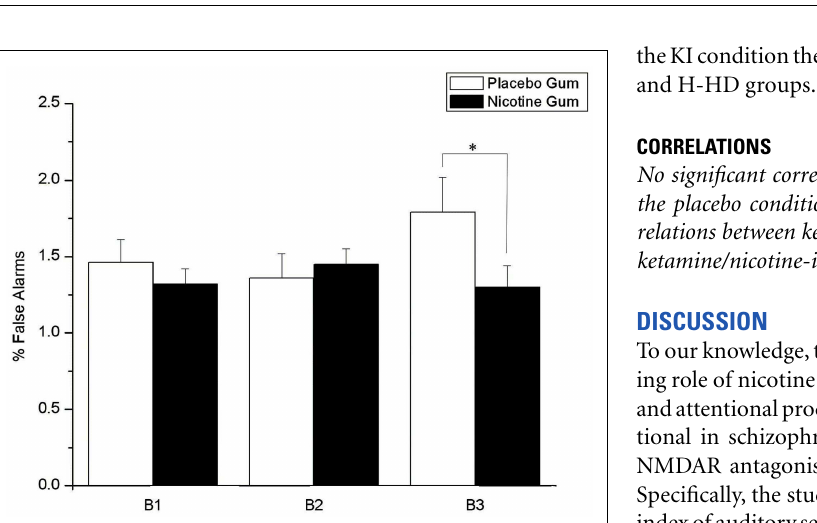
FIGURE 6 | Effects of placebo and nicotine gum (collapsed across placebo and ketamine infusions, and L-HD and H-HD groups) on mean ( ± SE) % false alarms in the three time blocks (B1–B3; * p <